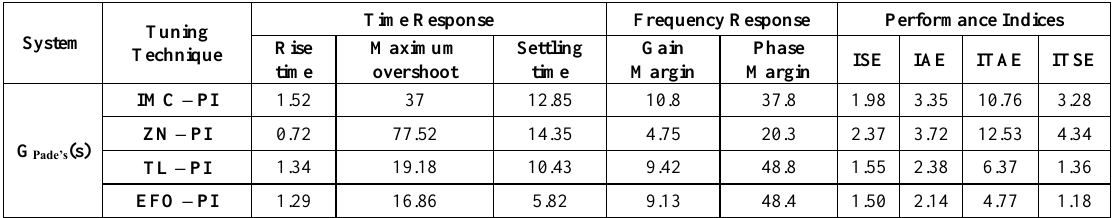
Table 8. Closed loop PI - controlled responses of G Pade’s (s)